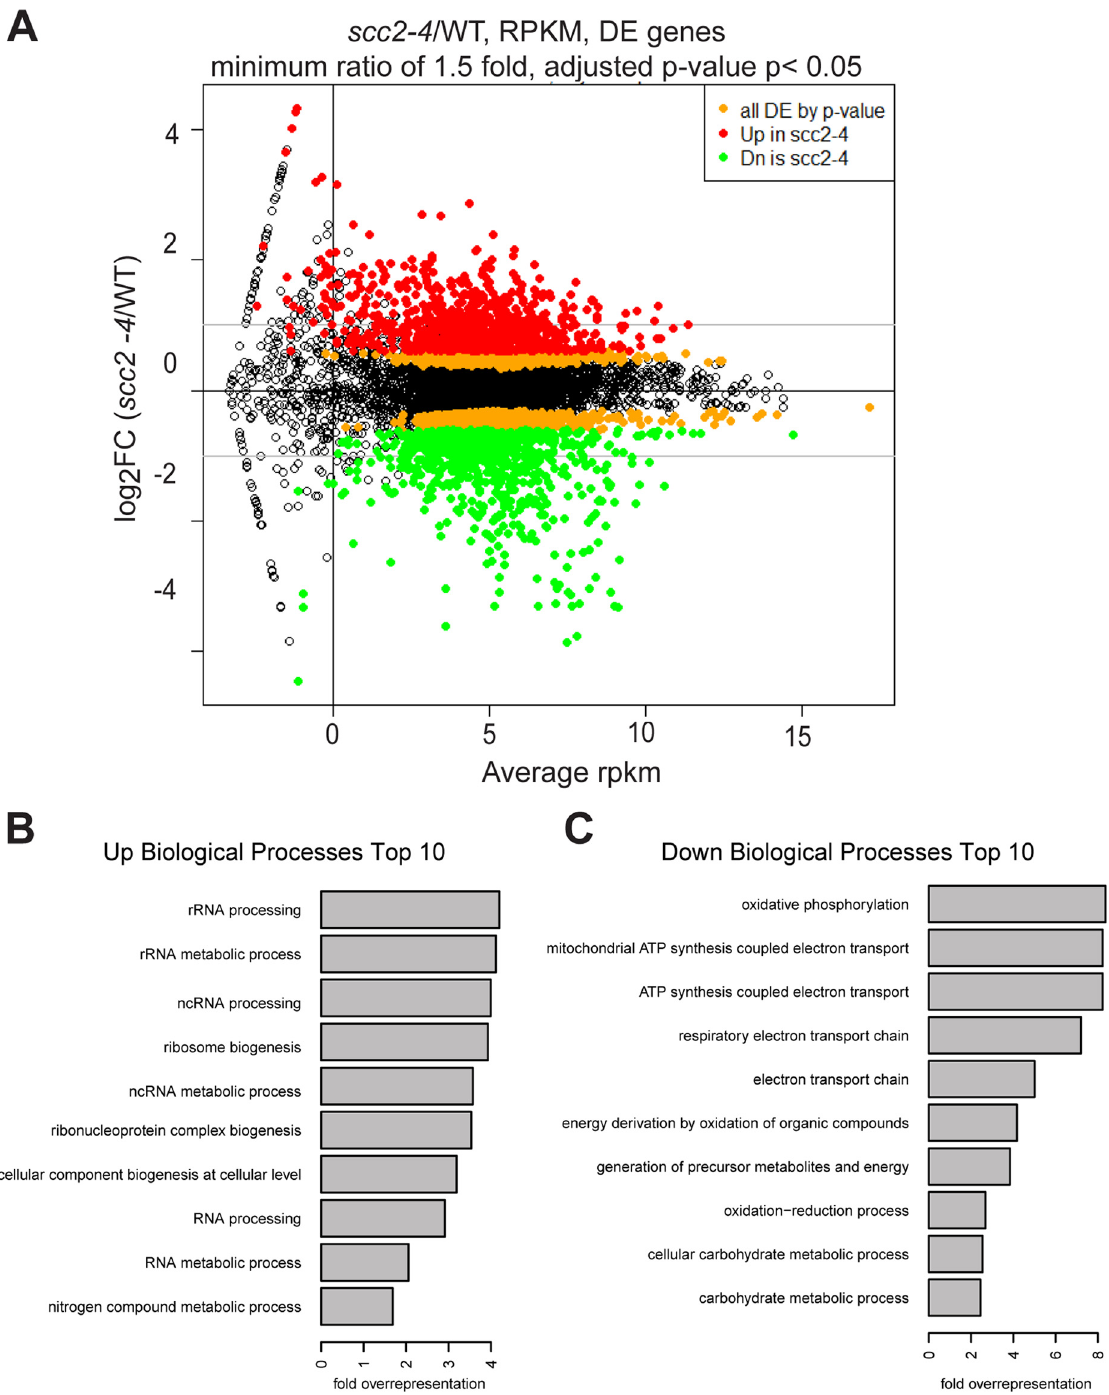
Fig 3. Hundreds of genes are differentially expressed in the scc2-4 mutant compared to WT at 30°C in YPD. (A) Gene expression values (mean of triplicate samples) are shown in MA plot. Differentially expressed genes (adjusted p-value < 0.05) were colored in orange, and then colored red or green after a minimum fold change cut-off of 1.5 was applied. There are 2644 genes differentially expressed genes in the scc2-4 mutant, with 1285 up-regulated and 1359 down-regulated. Applying a fold-change cutoff of 1.5 (corresponding to an absolute log 2 value of 0.6) returns a more reasonable number of genes for GO analysis and general comparison. (B) GO term analysis for the up-regulated genes shows enrichment for genes important for RNA processing/ metabolism and ribosome biogenesis. (C) GO term analysis for down-regulated genes shows enrichment for genes important for biological processes such as oxidative phosphorylation, electron transport chain, and carbohydrate metabolic processes.